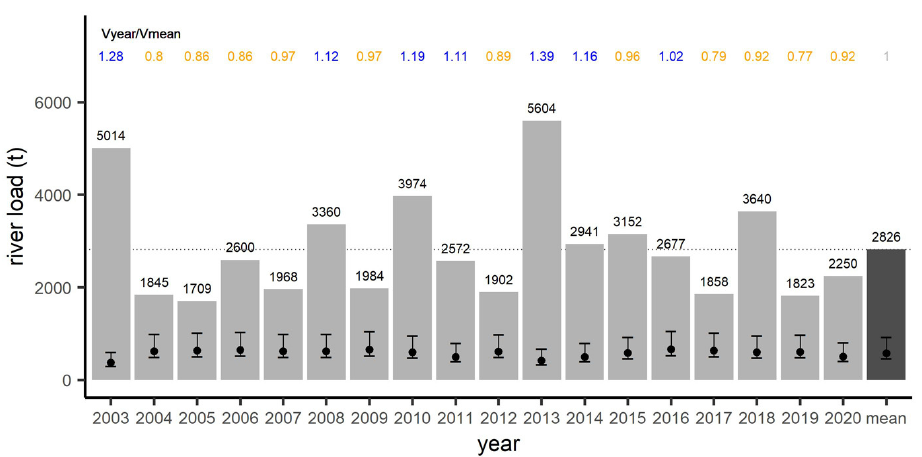
Figure 4. Annual suspended solid loads of the Kraichbach river for the years 2003–2020. Bars show the total suspended solid load, three variants of the dry-weather load calculations are shown as points (mean variant) and lines (minimum and maximum variants) in the bars. The ratio of the annual discharge volume (V year ) to the mean annual discharge volume (V mean ) is shown in blue for wet years and orange for dry years.